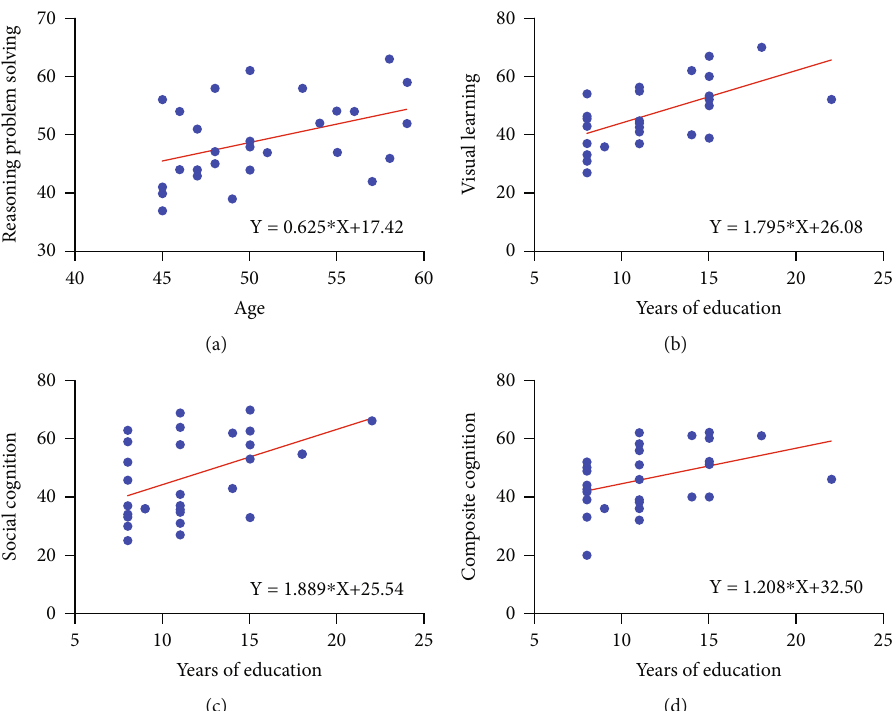
Figure 4: Correlations of cognitive function with patient baseline data in MDD group. (a) The correlation between reasoning problem- solving and age. (b) The correlation between visual learning and years of education. (c) The correlation between social cognition and years of education. (d) The correlation between composite cognition and years of education.